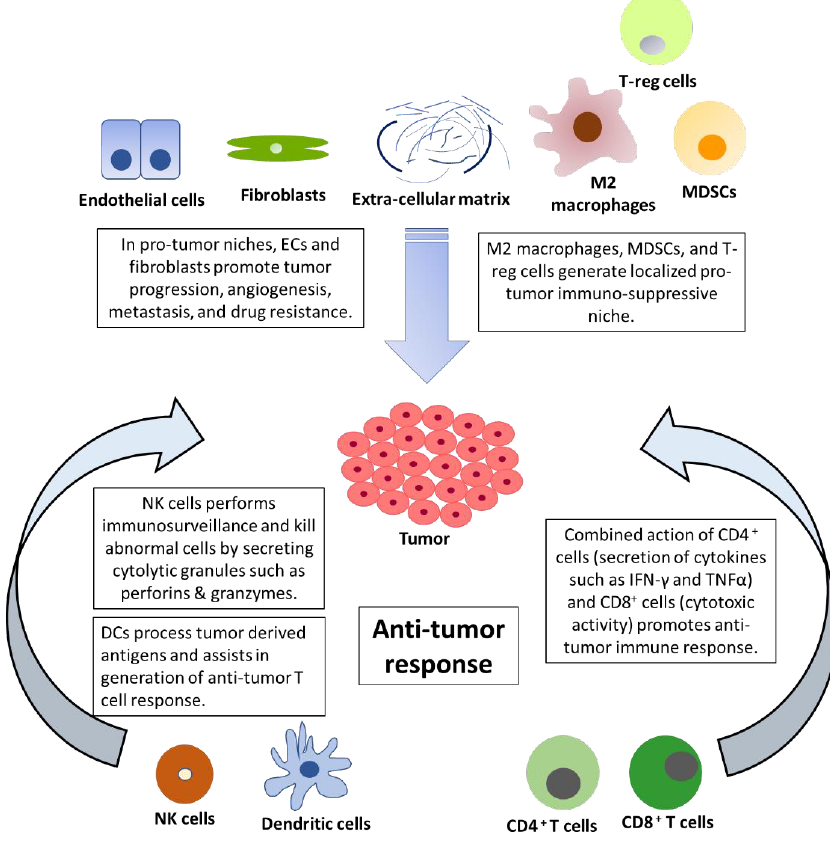
Figure 1. The opposing forces in the tumor microenvironment: the pro-tumor roles of fibroblasts, ECM, and suppressive immune cells against the anti-tumor immune response of NK cells, DCs, CD4 + , and CD8 + T